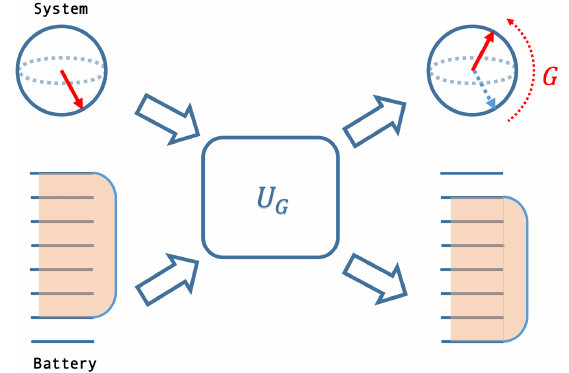
FIG. 1. Implementing a reversible gate using a battery. This figure describes a scheme that approximates a generic quantum gate G that may not preserve a generic type of resource, e.g., energy, on a system. The scheme works by using a battery system that undergoes a free unitary U together with the system. With G the resource supplied by the battery, G is approximated on the